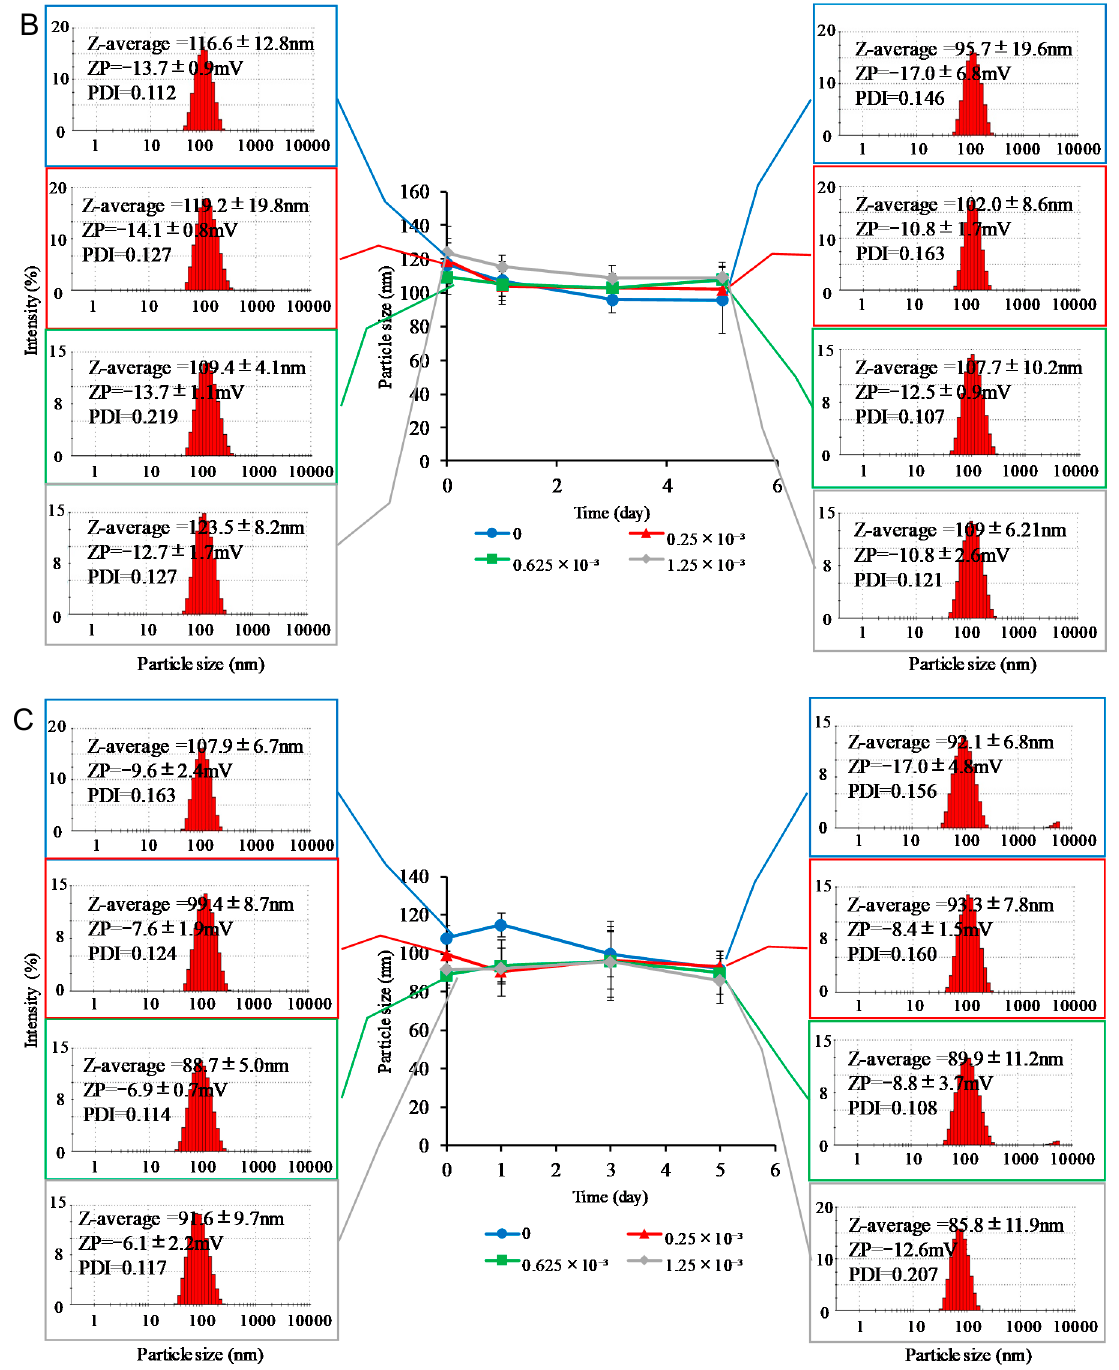
Figure 5. E ff ect of particle size with magnesium chloride, ( A ) changes in particle size and zeta potential of nanoparticles of DSPE-PEG2000 / Soluplus = 2 / 1 nanoparticles after the storage at 25 ◦ C day 0 to day 5; ( B ) changes in particle size and zeta potential of nanoparticles of DSPE-PEG2000 / Soluplus = 1 / 1 nanoparticles after the storage at 25 ◦ C day 0 to day 5; ( C ) changes in particle size and zeta potential of nanoparticles of DSPE-PEG2000 / Soluplus = 1 / 2 nanoparticles after the storage at 25 ◦ C day 0 to day 5.